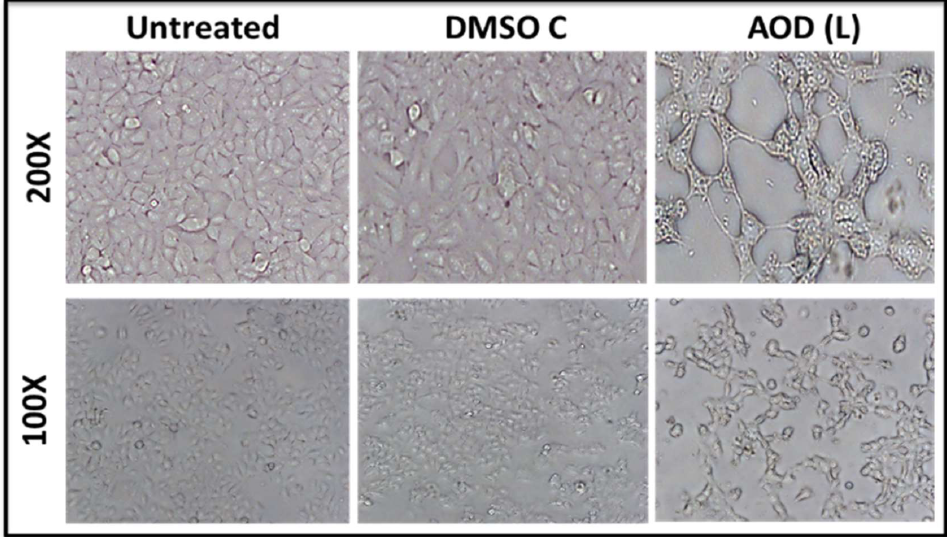
Figure 4. Photomicrographs of MCF-7 cells treated with 250 µg/mL of A. orientalis dichloromethane leaf fraction (AOD (L)), 30 h post treatment. DMSO C, DMSO control having the same amount of DMSO as the test sample.